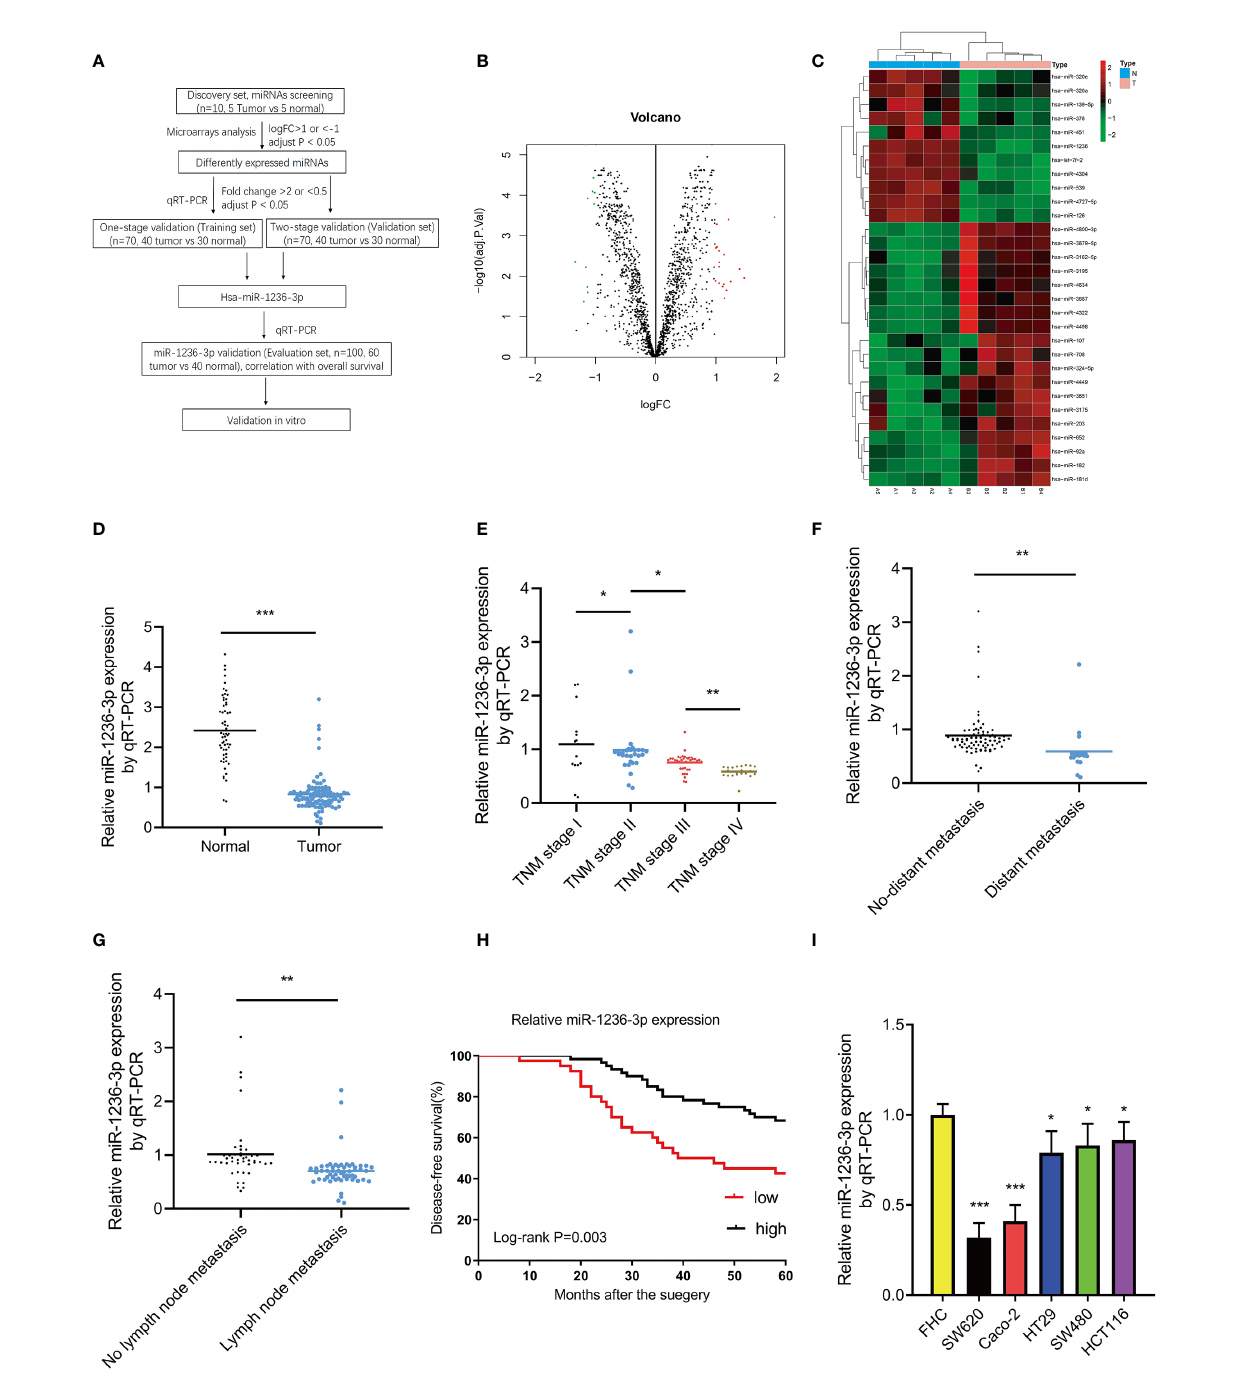
FIGURE 1 | MiR-1236-3p was signi fi cantly downregulated in colon cancer tissues. (A) Flow chart of this study. (B) Volcano plot of the miRNAs. The red and green points represent differently expressed miRNAs (logFC > 1 or < − 1 and adjust P value < 0.05). (C) Heatmap of differently expressed miRNAs (including 19 upregulated and 11 downregulated miRNAs). (D) Relative miR-1236-3p expression in normal colon and colon cancer tissues by qRT-PCR with U6 RNA as normal control. Relative miR-1236-3p expression and TNM stage (E) , distant metastasis (F) , and lymph node metastasis (G) to U6 by qRT-PCR in the evaluation set. A lower miR- 1236-3p expression was signi fi cantly associated with a higher TNM stage, a presence of distant metastasis, and lymph node metastasis. (H) Relative miR-1236-3p expression and 5-year disease-free survival. (I) Relative miR-1236-3p expressions in cell lines to FHC by qRT-PCR (six replicates per group). The relative miR-1236- 3p expressions in SW620, Caco-2, HT29, SW480, and HCT116 cell lines were signi fi cantly lower than FHC. FC, fold change; qRT-PCR, quantitative reverse transcription – polymerase chain reaction; hsa, human; N, normal; T, tumor; Error bars represent the mean ± s.e.m; *P < 0.05, **P < 0.01, ***P < 0.001 by Student ’ s t-test. The relationship between miR-1236-3p and disease-free survival was evaluated by Kaplan – Meier analysis with log-rank